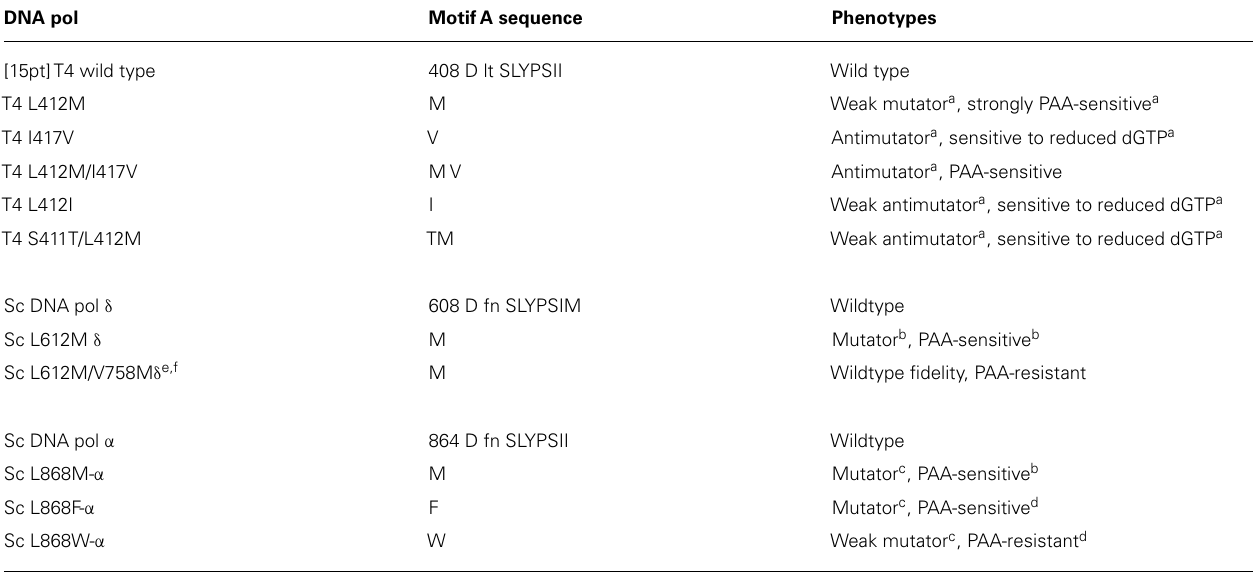
a Data from Table 2 and Reha-Krantz and Nonay (1994). b Data from Li etal. (2005); mutator phenotype observed in the absence of mismatch repair. c Data from Niimi etal. (2004). d Unpublished observations,